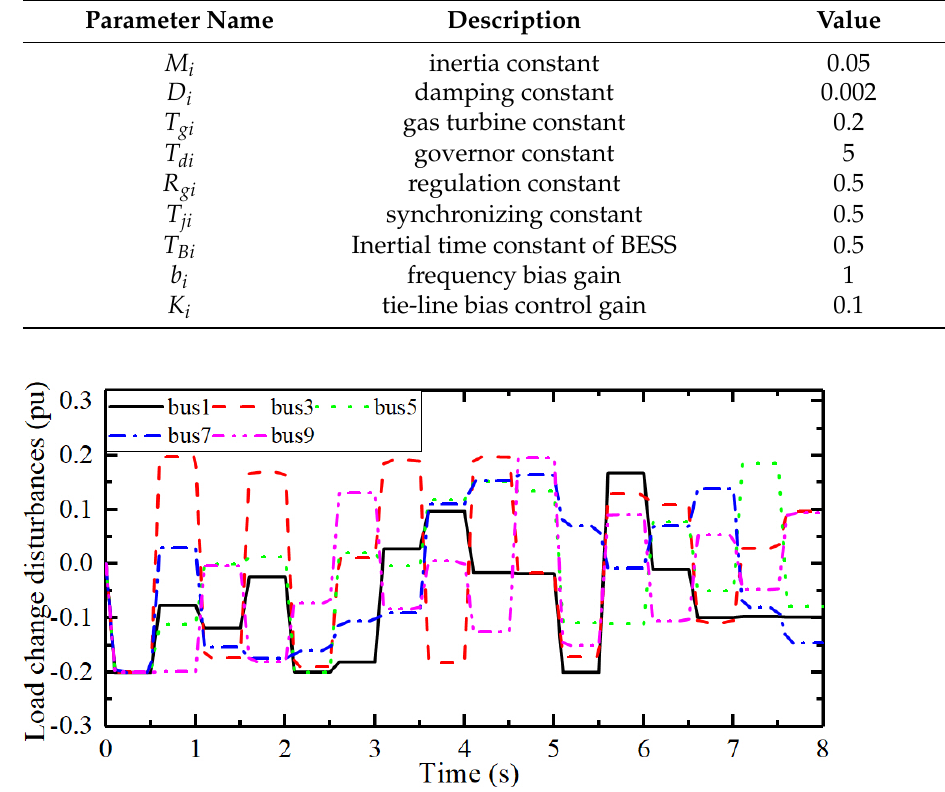
Figure 4. Multi-step random load change